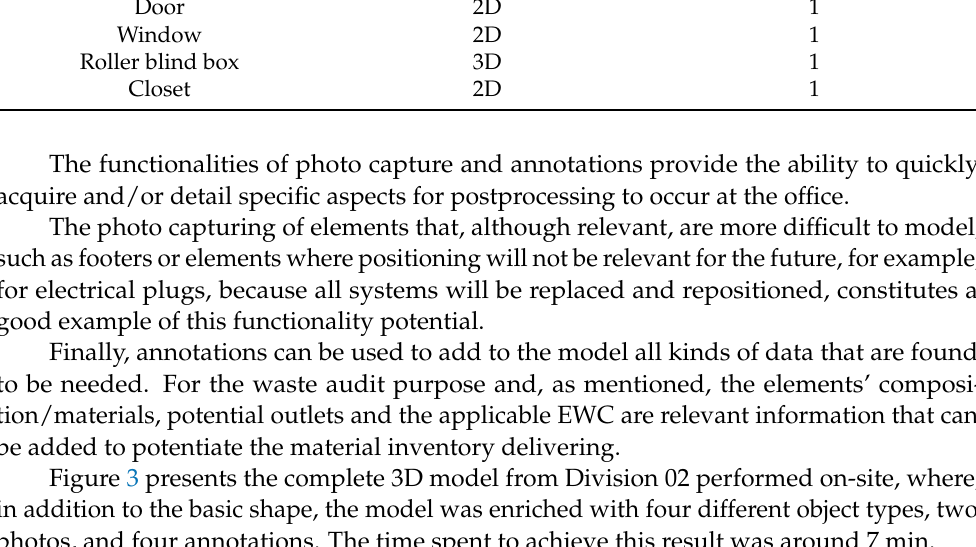
Table 5. Summary of the scan process of all divisions on the sample apartment.